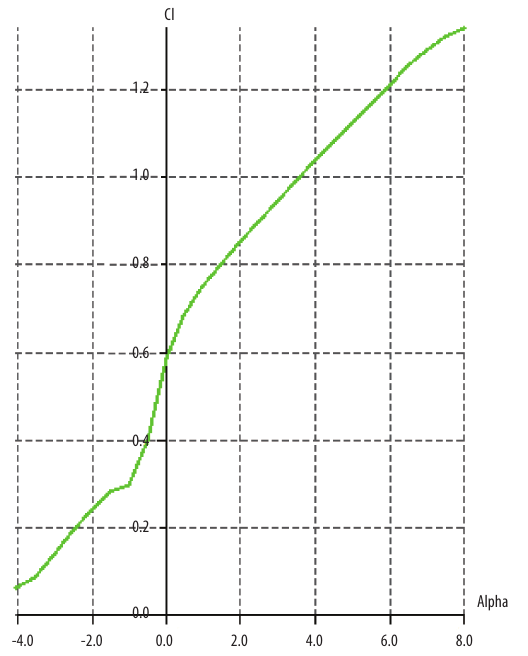
Fig. 4. Dependence of lift force on the angle of attack